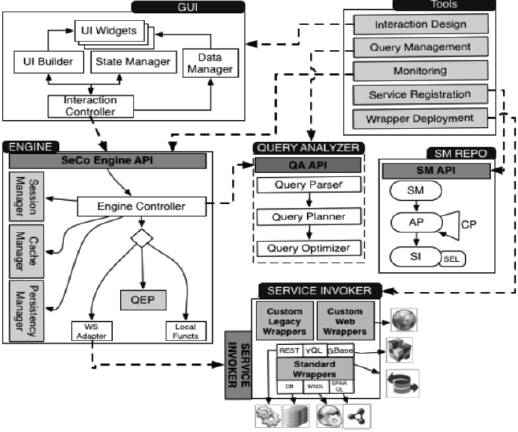
Figure 1: Search computing